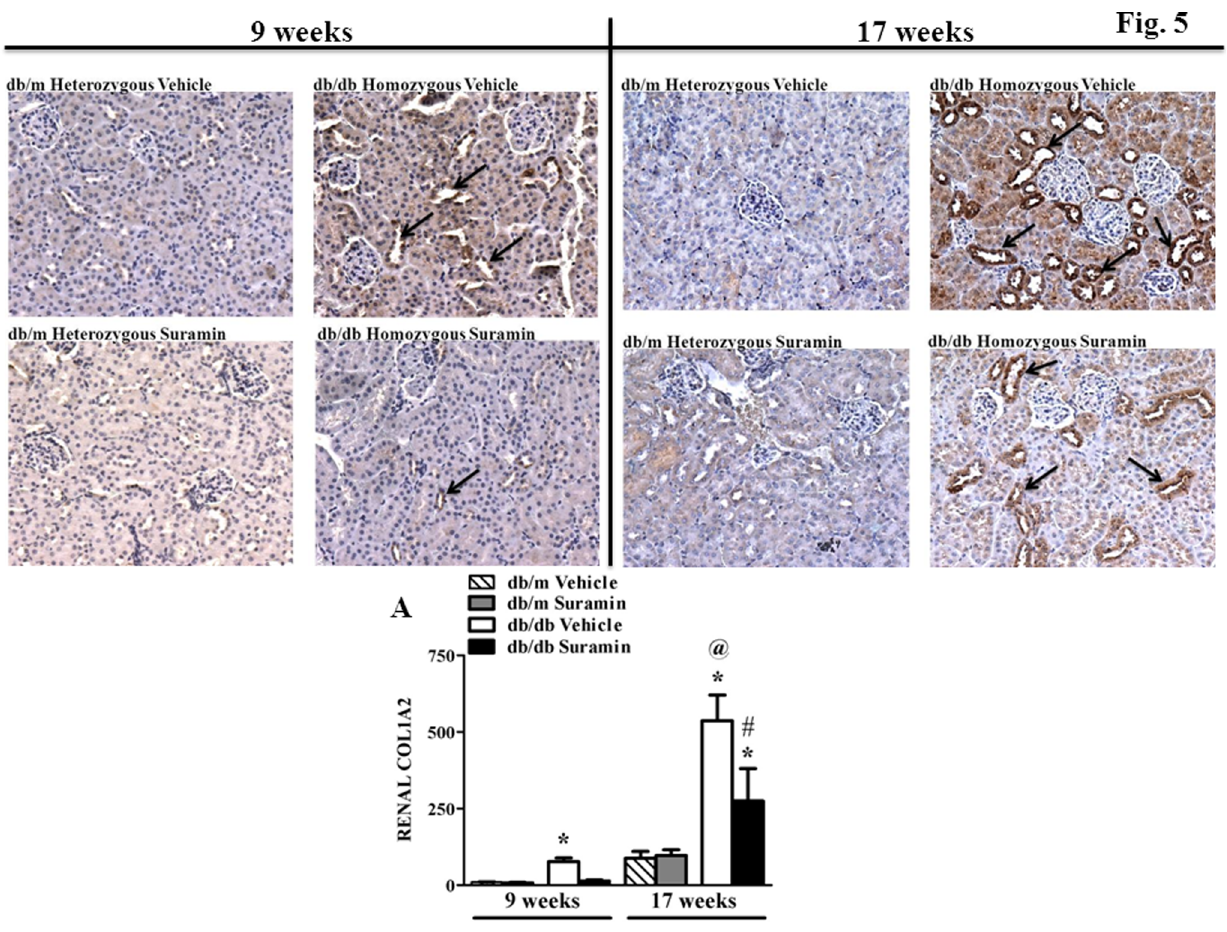
Figure 5. Effect of delayed administration of suramin on deposition of renal fibrogenic material COL1A2 in 9/17 week db/db mice. Mice were treated as described in Figure 1. Representative photomicrographs of COL1A2 deposition in kidney sections from 9/17 week non-diabetic and diabetic mice 6 suramin intervention, respectively. All fields were chosen from the cortical regions of the kidney sections. Original magnification, 200 X. A . Quantitative analysis of renal COL1A2 assessed by brown staining in the epithelial cells lining the proximal tubules (arrows) in a total of 25 fields in the cortical region of kidney sections. Data are expressed as mean 6 SE (n=4). * Significantly different from respective non-diabetic db/m mice ( p # 0.05). # Significantly different from vehicle-treated diabetic db/db mice ( p # 0.05). @ Significantly different from vehicle-treated 9 week diabetic db/db mice ( p # 0.05).